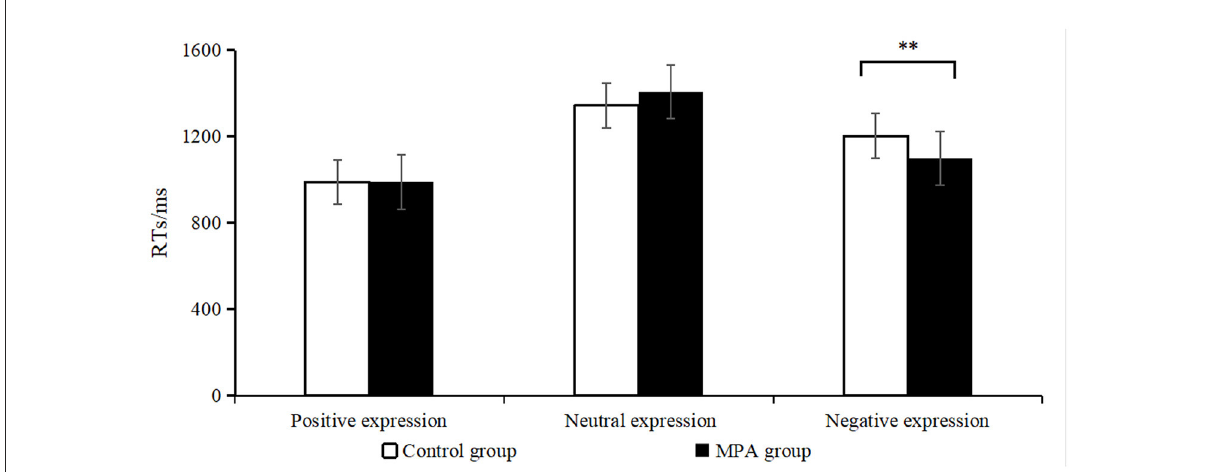
FIGURE3 Comparison of average RTs in the emotional visual search task. MPA, mobile phone addiction. The error bar in this figure means standard error (SE). ** p <